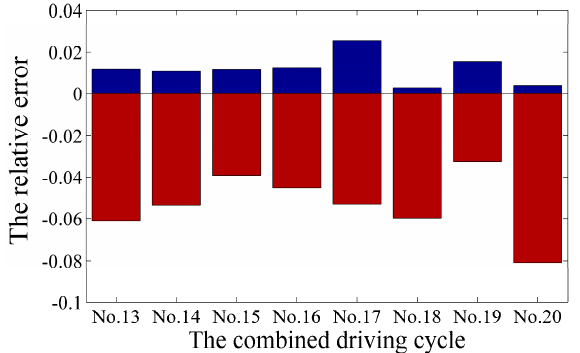
Figure 10. The relative errors between the reference and the optimal SOCs.